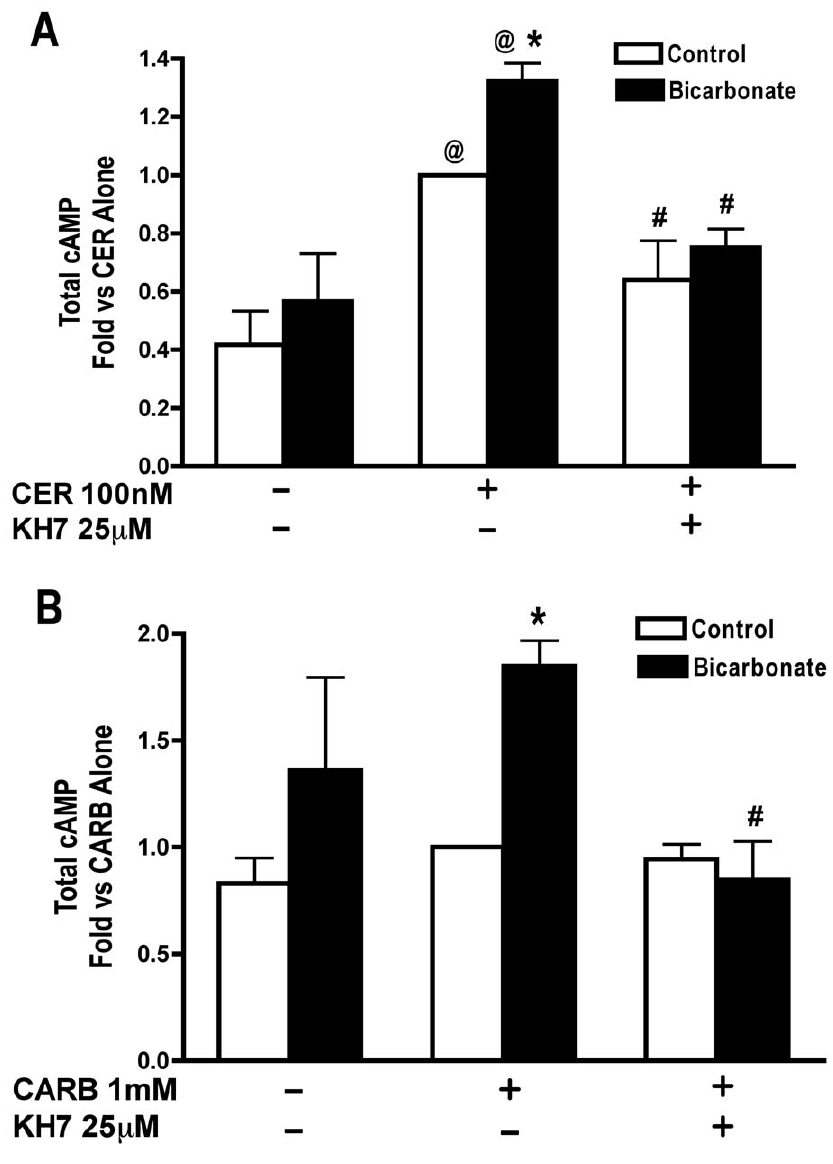
Figure 7. Secretagogue stimulated cAMP accumulation is enhanced by bicarbonate treatment and is inhibited by the sAC inhibitor KH7. Acini were treated with or without either the sAC inhibitor KH7 [25 m M] for 2 hours. During the last 15 min, IBMX was added [1 mM]. Media was changed and inhibitors where re-added when appropriate. Media used for the change contained either bicarbonate [25 mM] at a constant flow of air/CO 2 (95/5%) or no added bicarbonate under room air conditions. Secretagogue, CER 100 nM (A) or CARB 1 mM (B) was added immediately after media change to the appropriate wells and acini incubated for 1 hour. Acini were collected and assayed for cAMP accumulation. *p , 0.05 comparing treatments with and without bicarbonate, # p , 0.05 vs corresponding treatment without KH7, @ p , 0.05 vs corresponding control without secretagogue. (n $